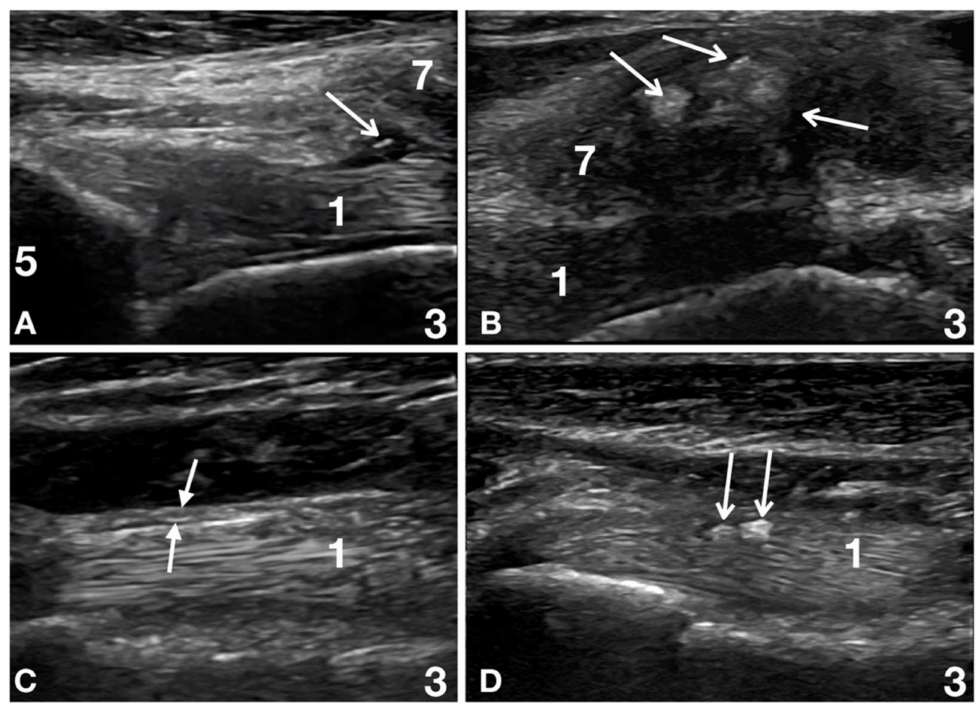
Figure 4. In some of the degenerative lesions, not considered clinically relevant but still present at Time 6, ultrasonographic evaluation is shown. ( A ) Patient 27: right shoulder at the level of the biceps tendon (1) supraglenoid origin (5) at Time 6. A well-defined, fibre-rich, uniform in diameter biceps tendon (1) is effacing a focal dilatation of the tendon sheath, which presents a plaque-like, thin, mineralised lesion (empty arrowhead). At the dynamic examination, the plaque-like mineralised structure was attached to the tendon sheath, and the limited effusion prevented friction with the biceps tendon. The patient was competing with no issues six months after the end of the physical therapy. ( B ) Patient number 3: left shoulder at Time 6. Several mineralised lesions (empty arrowhead) create a clean acoustic shadow and partially hide the biceps tendon underneath. These lesions were present at the first presentation (not the only lesions present) and did not change between examinations, despite the different clinical signs of the patient over time. As reported in the literature, mineralised lesions in the supraspinatus tendon are often not considered to be clinically significant unless they are on the surface of the tendon and interfere with the movements of the joint capsule and the biceps tendon underneath. ( C ) Patient number 15: left biceps tendon (1) distal to the bicipital groove, Time 6. There is a uniformly thickened tendon sheath (between the full arrowheads) in this patient. The dog was performing well six months after the end of physiotherapy. The smooth surface and lack of associated tendon sheath effusion are relevant factors in defining this thickness not to be clinically relevant. The tendon sheath may be back to its original thickness over time. ( D ) Patient number 9: left biceps tendon (1) distal to the bicipital groove, Time 6. A well-defined, fibre-rich, uniform biceps tendon (1) is adjacent to two large, rounded, hyperechoic structures (empty arrowheads). At the dynamic examination, the rounded, most likely partially mineralised (acoustic shadowing was partially present) were attached to the tendon sheath and were sliding, apparently not causing friction with the biceps tendon. The patient was performing well six months after the end of the physical